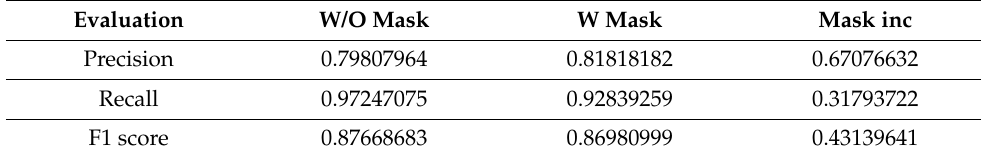
Table 2. Evaluation results of precision, recall, and f1 score.